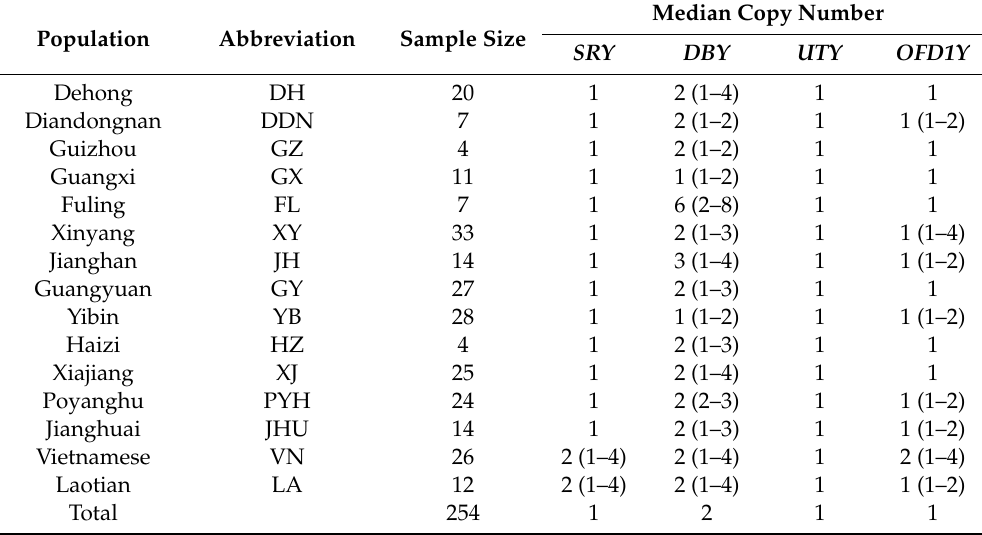
Laotian LA Total